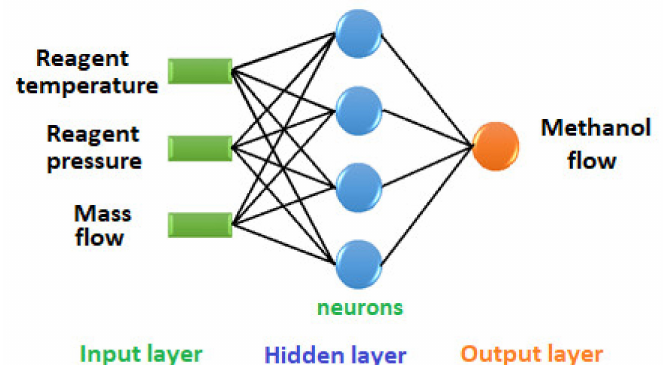
Figure 3. The ANN designed.